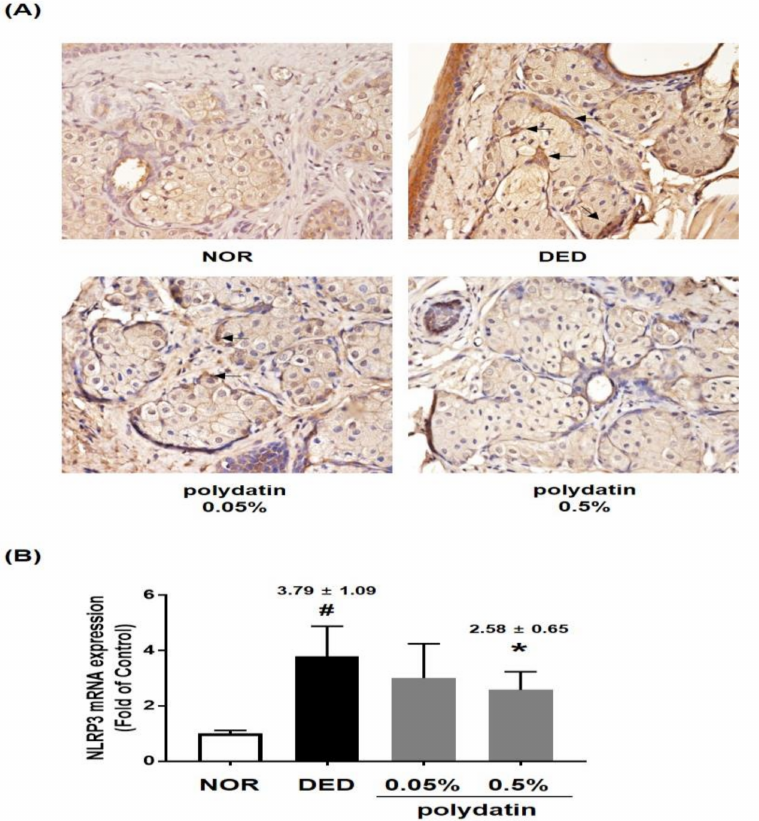
Figure 4. E ff ect of polydatin on NLRP3 inflammasome in exorbital lacrimal gland-excised rats. ( A ) Immunohistochemical staining for NLRP3. ( B ) mRNA level of NLRP3 was examined by real-time PCR assay. GAPDH was considered an internal control. Data are the mean ± SEM of three independent experiments for all groups. # p < 0.05, significantly di ff erent from normal mice, * p < 0.05, significantly di ff erent from vehicle-treated dry eye